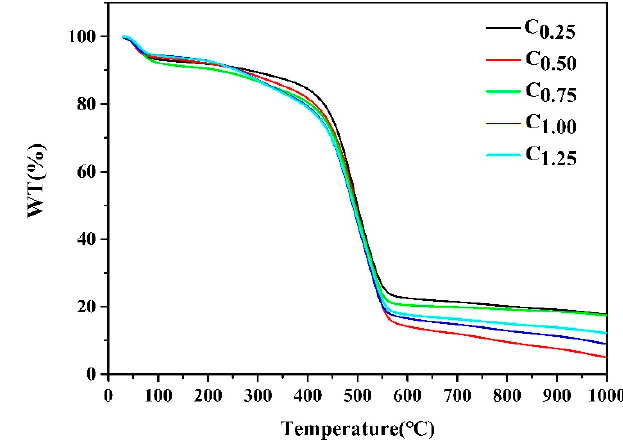
Figure 3. TGA analysis of different types of the cystamine-modified biochars.